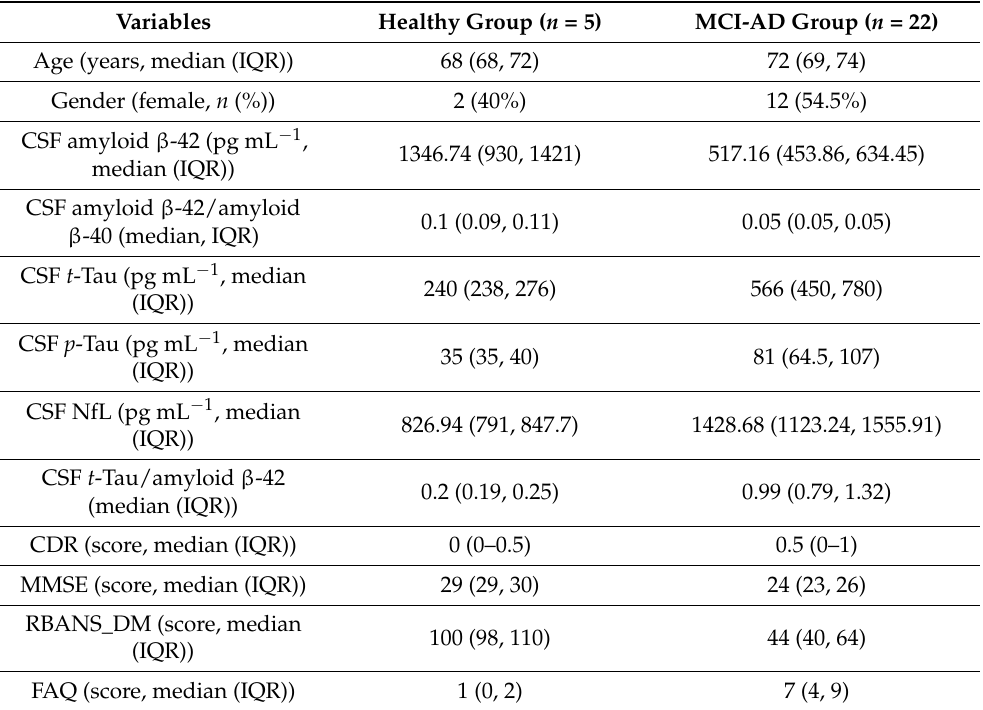
Table 2. Demographic and clinical characteristics of the